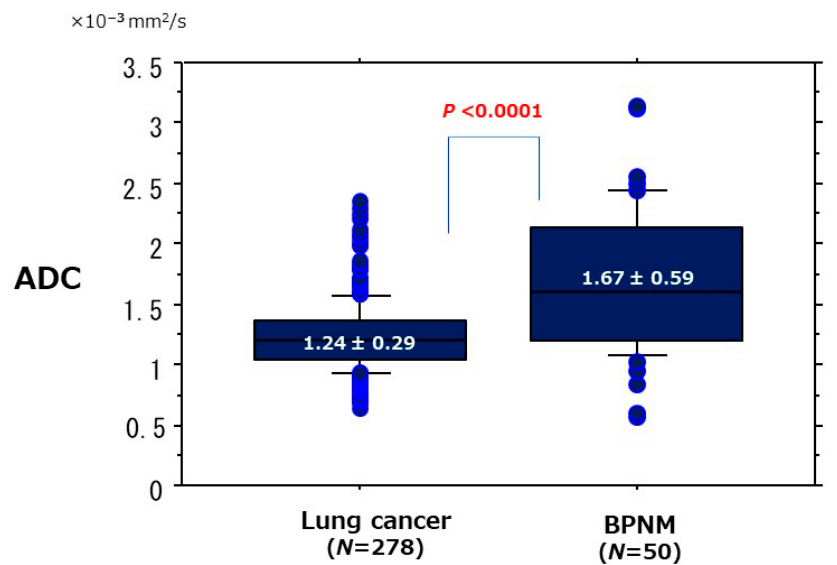
Figure 10. Relationships between the mean ADC and lung cancer/BPNM. The mean ADC (1.24 ± 0.29 × 10 − 3 mm 2 /s) of lung cancer was significantly lower than that (1.67 ± 0.59 × 10 − 3 mm 2 /s) of BPNM ( p < 0.0001).